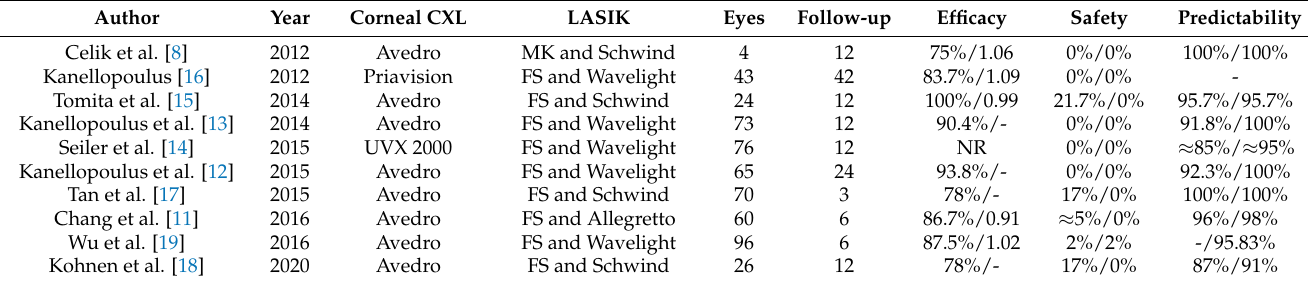
Table 2. Prophylactic CXL with LASIK results among previous studies. Efficacy. Percentage postoperative uncorrected binocular distance and visual acuity (UDVA) (with 20/20 or better) (Efficacy index is also shown if available). Safety. Percentage of eyes with corrected distance visual acuity (CDVA) with one and two lines of loss or more. Predictability. Percentage of eyes with spherical equivalent refraction accuracy within ± 0.50 and ± 1.00 D. Stability. Percentage of eyes with a change of 0.50 D or more between an intermediate and final month of follow-up. Follow-up is reported in months. LASIK procedure is reported first flap technique and second excimer laser